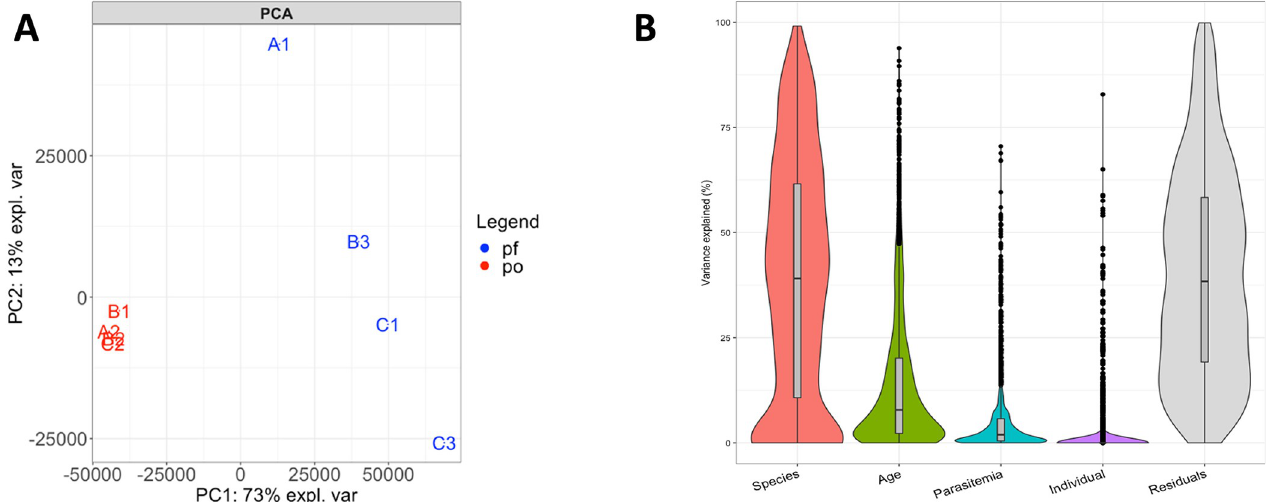
Fig 2. Plasmodium gene expression profiles during symptomatic infections cluster according to the infecting species. (A) PCA showing the relationships among the eight infections based on the expression level of 2,631 Plasmodium genes and colored according to the infecting species (blue– P . falciparum , red– P . ovale ). ( B) Percentage of the variance in parasite gene expression explained by the infecting species, the age of the child, the parasitemia of the infection and the individual.